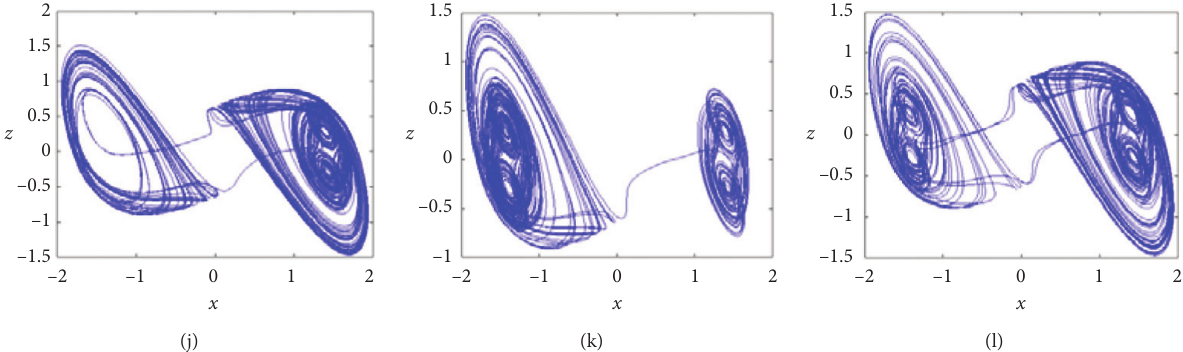
Figure 3: Some typical phase portraits with different parameter a . (a, b) A pair of asymmetric single-scroll chaotic attractors. (b) A pair of asymmetric single-scroll chaotic attractors. (c, d) A pair of symmetric double-scroll chaotic attractors. (e, f) Two different double-scroll chaotic attractors. (g, h) Two different composite 3-scroll chaotic attractors. (i, j) A pair of symmetric composite 4-scroll chaotic and hyperchaotic attractors. (k) A composite 5-scroll chaotic attractor. (l) A composite 6-scroll hyperchaotic attractor. Table 1: Composite one- to six-scroll attractors of system (3) with variation of parameter a . Parameter a The number of scrolls of hidden